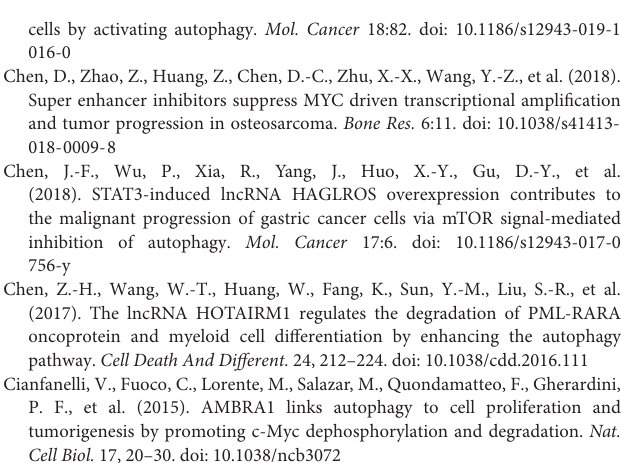
Supplementary Figure 1 | (A–C) The relationship between autophagy-related markers and metastasis. (D–F) The calibration curve of the nomogram. Supplementary Table 1 | Primers used in this study. Supplementary Table 2 | Risk coefficients of six ARLs. Supplementary Table 3 | Risk coefficients of three